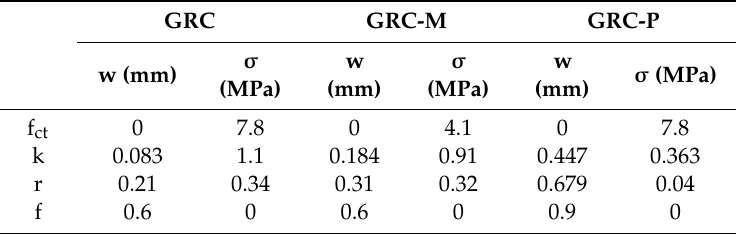
Table 4. Parameters of the fibre-reinforced cementitious materials (FRC) softening functions.